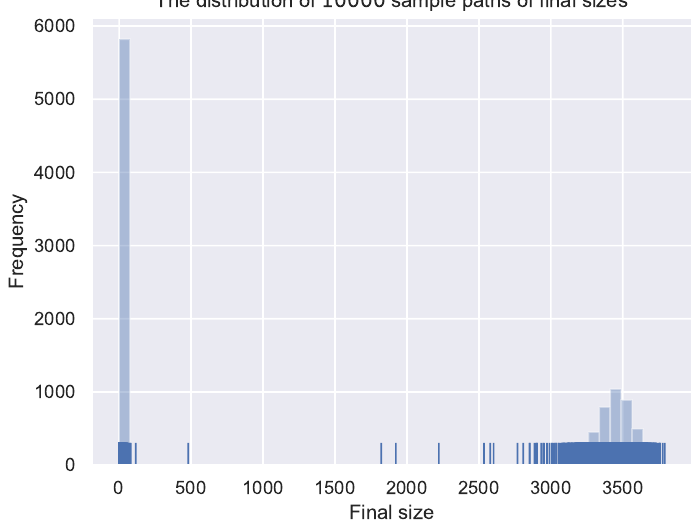
Figure 8. The distribution of the final sizes of 10 4 realizations for the CTMC model (3) with five exposed stages (simulated with SSA).